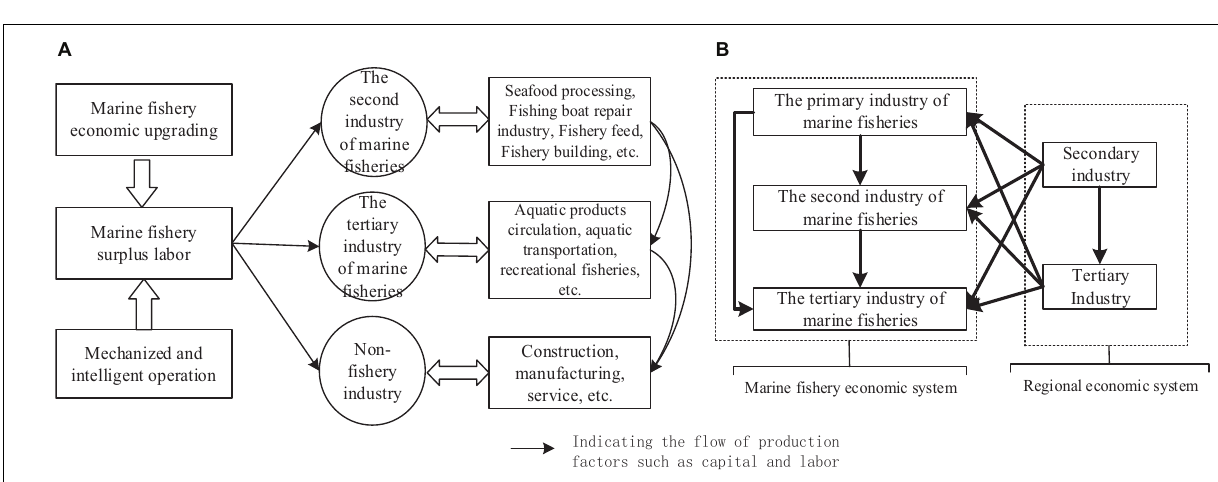
Frontiers in Marine Science |